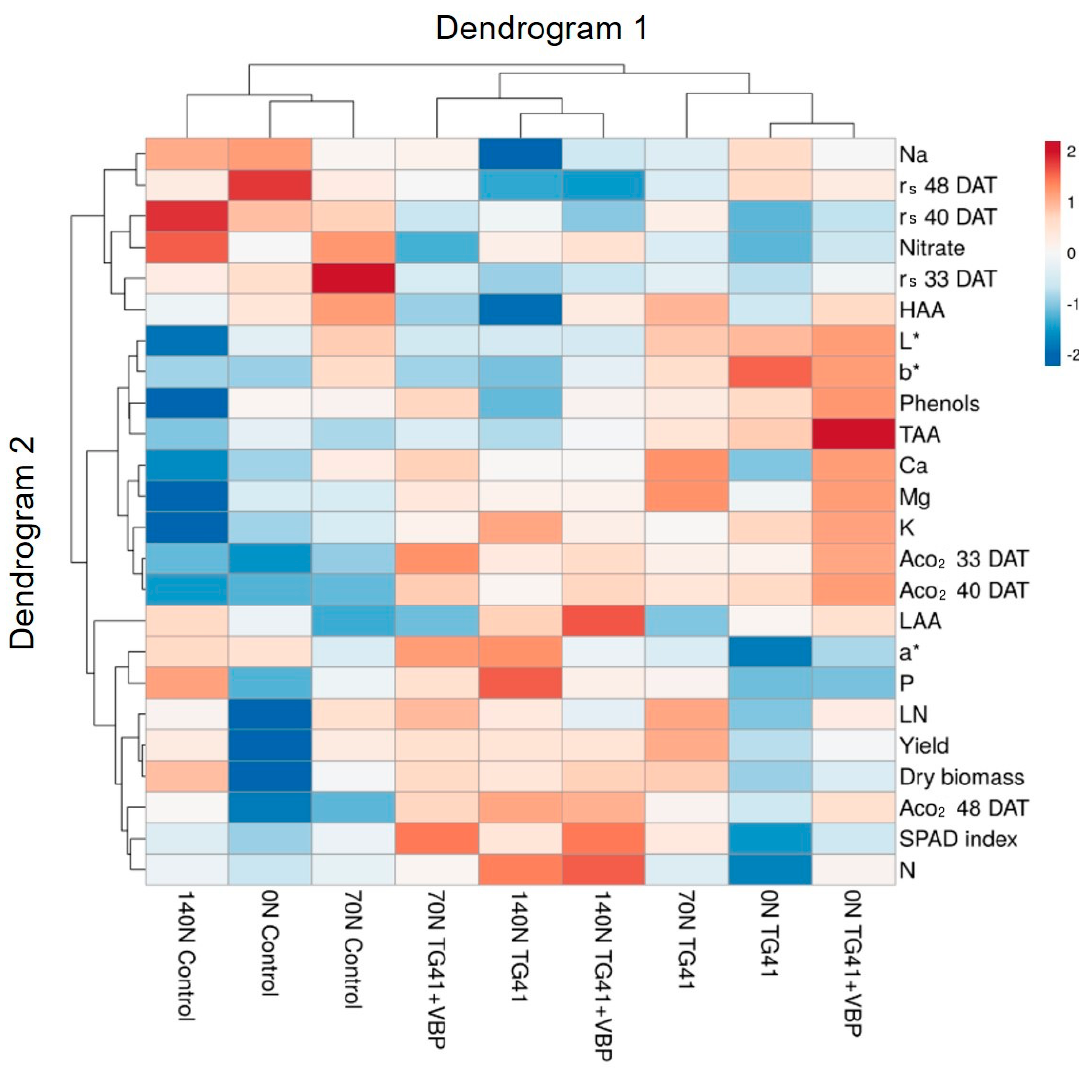
Figure 2. Cluster heat map analysis summarizing greenhouse lettuce plant responses to a factorial experiment with three N fertilization levels (0N = 0 kg ha − 1 , 70N = 70 kg ha − 1 , 140N = 140 kg ha − 1 ) and